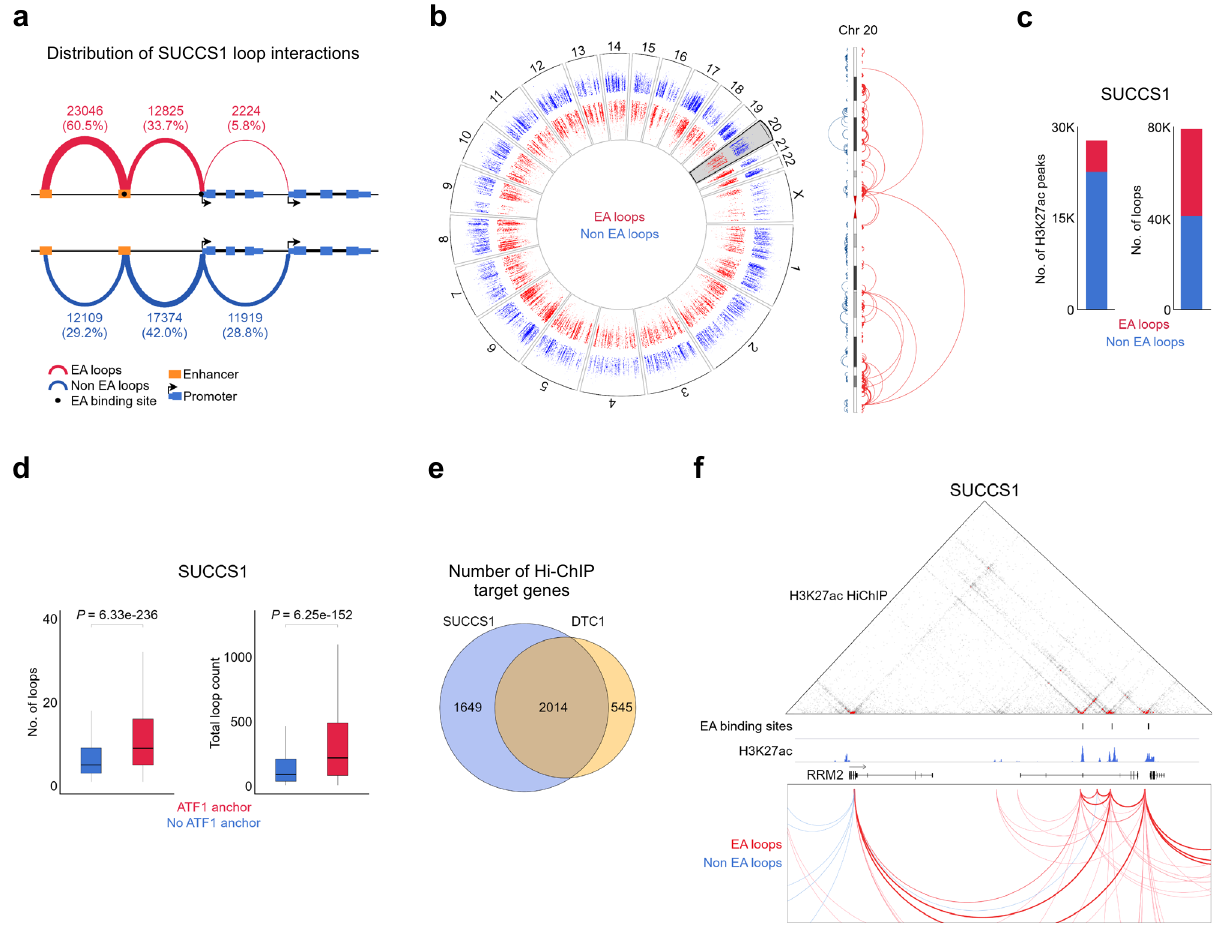
Fig. 5 EWSR1-ATF1-associated connectivity dominates the 3D landscape of CCS tumor cells. a Three-dimensional connectivity of EWSR1-ATF1- associated (EA loops, red) or – independent (Non EA loops, blue) chromatin loops in SU-CCS-1 tumor cells, showing a more distal-to-distal interaction pattern for fusion protein-connected loops. b Left : circos plot depicting all EWSR1-ATF1-associated or -independent chromatin loops genome-wide. The height of the blue and red signals inside the circos corresponds to the loop ’ s length depicted in log10 scale. Right : higher magni fi cation of chromosome 20 illustrating increased length for EWSR1-ATF1-associated loops, as compared to all other loops. c Bar plots showing the association of H3K27ac peaks ( left ) and chromatin loops ( right ) with EA loops (5121 and 38095, respectively) or Non-EA loops (22654 and 41402, respectively). d Box plots depicting the median number ( left ) and intensity ( right ) of chromatin loops associated ( n = 38095) or not ( n = 41402) with EWSR1-ATF1 binding sites. The lower and upper hinges correspond to the fi rst and third quartiles (the 25th and 75th percentiles). The upper whisker extends from the hinge to the largest value no further than 1.5 * IQR from the hinge (where IQR is the inter-quartile range). The lower whisker extends from the hinge to the smallest value at most 1.5 * IQR of the hinge. Statistical signi fi cance was calculated by two-sided t-test ( n = 4181 forATF1 anchors, n = 16756 for No ATF1 anchors). e Venn diagram presenting the number of direct target genes identi fi ed by Hi-ChIP as connected to the 2385 EWSR1-ATF1 binding sites in SU-CCS-1 and DTC1 tumor cells. f Hi-ChIP interaction map ( top ) and chromatin looping pro fi le ( bottom ) for the RRM2 genomic locus in SU-CCS-1 tumor cells. EWSR1-ATF1 (EA) binding sites and H3K27ac ChIP-seq signal are also shown ( middle ). Chromatin loops in the bottom panel are color-coded depending on their association (EA loops, red) or not (Non EA loops, blue) with the fusion protein binding